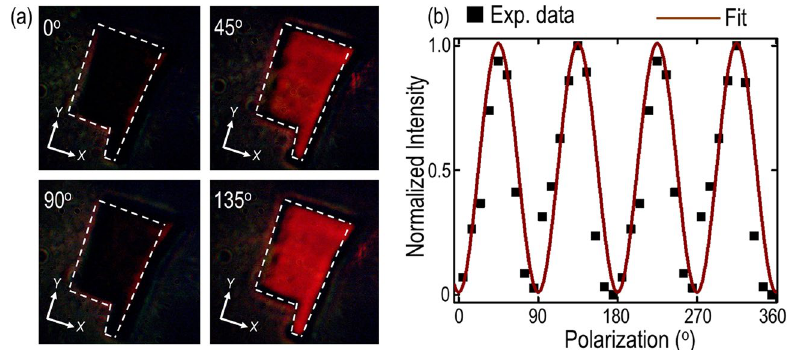
Figure 5. Birefringence effect in gerstleyite crystal. ( a ) Captured optical transmission microscope images of the 472 nm-thick gerstleyite flake under the cross-polarization illumination configuration at four different incident linear polarization angles of 0°, 45°, 90° and 135°. The investigated gerstleyite flake boundary is indicated with white dashed lines. The other experimental parameters such as incident beam intensity and image exposure time are kept same during the measurement. ( b ) Quantification of the transmitted light intensity as a function of the incident linear polarization angle under the cross-polarization illumination configuration. Black squares signify the experimentally extracted values, whereas brown solid curve shows the theoretical